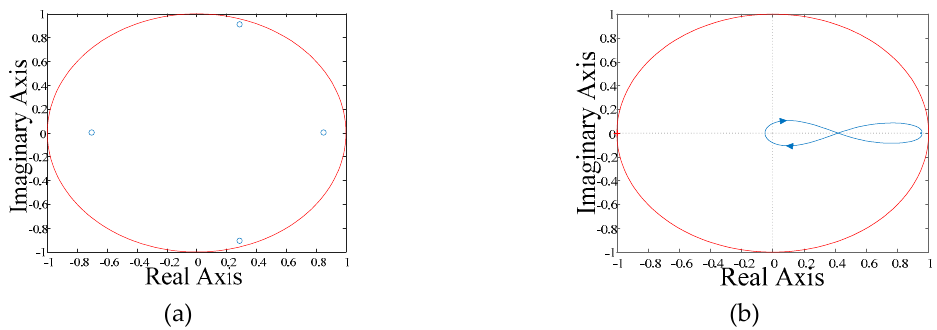
Figure 9. Sufficient stability criterion under resistor-inductor (RL) load. (a) Pole diagram of T(z) under RL load. (b) Nyquist diagram of H(z) under RL load.